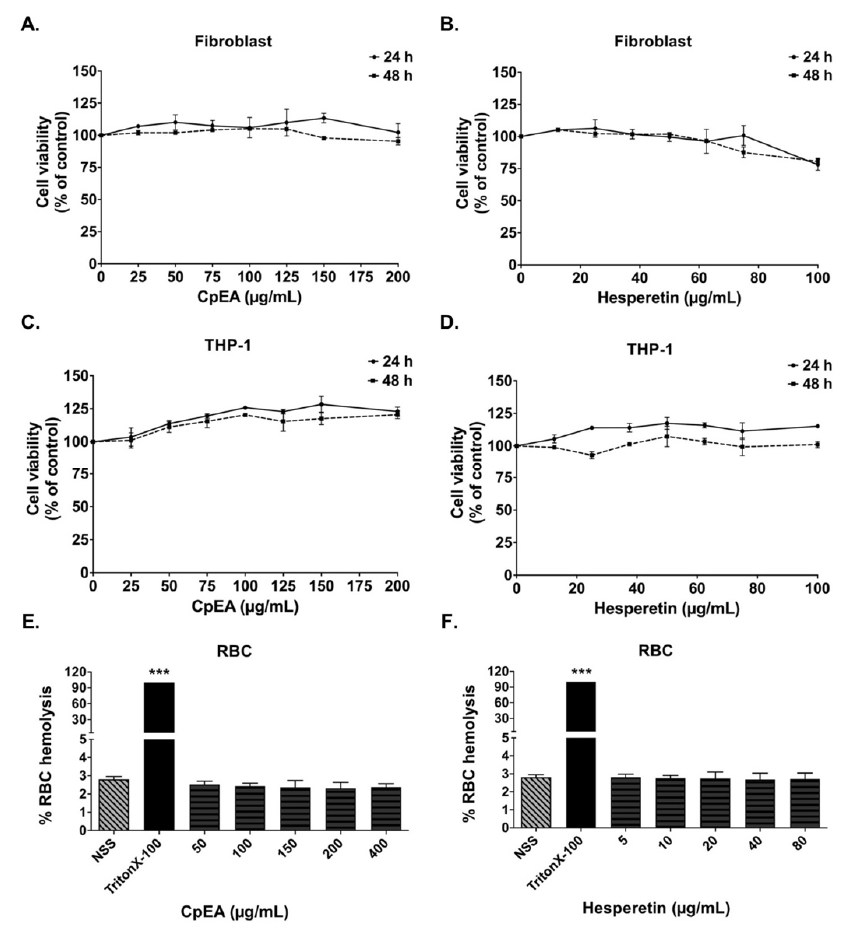
Figure 2. Effects of ethyl acetate fraction of C. petasites (CpEA) and hesperetin on normal cell viability. Cells were treated with CpEA and hesperetin for 24 and 48 h. Cell survival was determined using SRB assay for human dermal fibroblasts ( A , B ) and THP-1 macrophages ( C , D ). Effects of CpEA ( E ) and hesperetin ( F ) on red blood cells (RBCs) were determined using RBC hemolysis assay, TritonX-100 was used as positive control. Data are presented as mean ± S.D. values of three independent experiments. *** p < 0.001 vs. negative 0.9% normal saline (NSS) control.